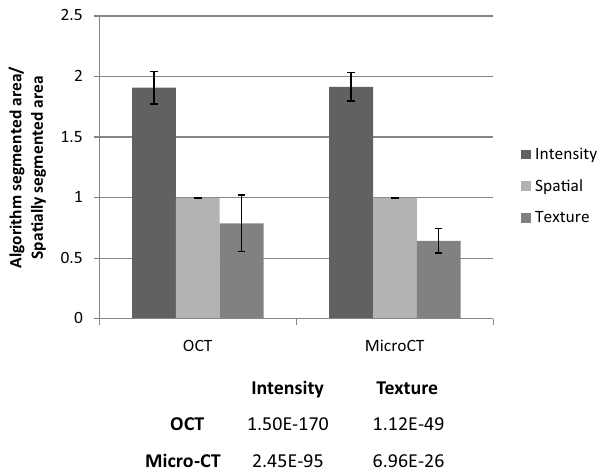
Fig. 7. Comparison of automatic segmentation algorithms. Areas of tumor segmented by each algorithm are normalized to areas from the spatial frequency algorithm ( n ¼ 1250 for OCT, n ¼ 760 for micro-CT), with error bars representing standard deviation. A Student's t -test comparing the means of the areas found by each method with the area obtained by the spatial frequency ¯lter was performed. The p -values are shown in